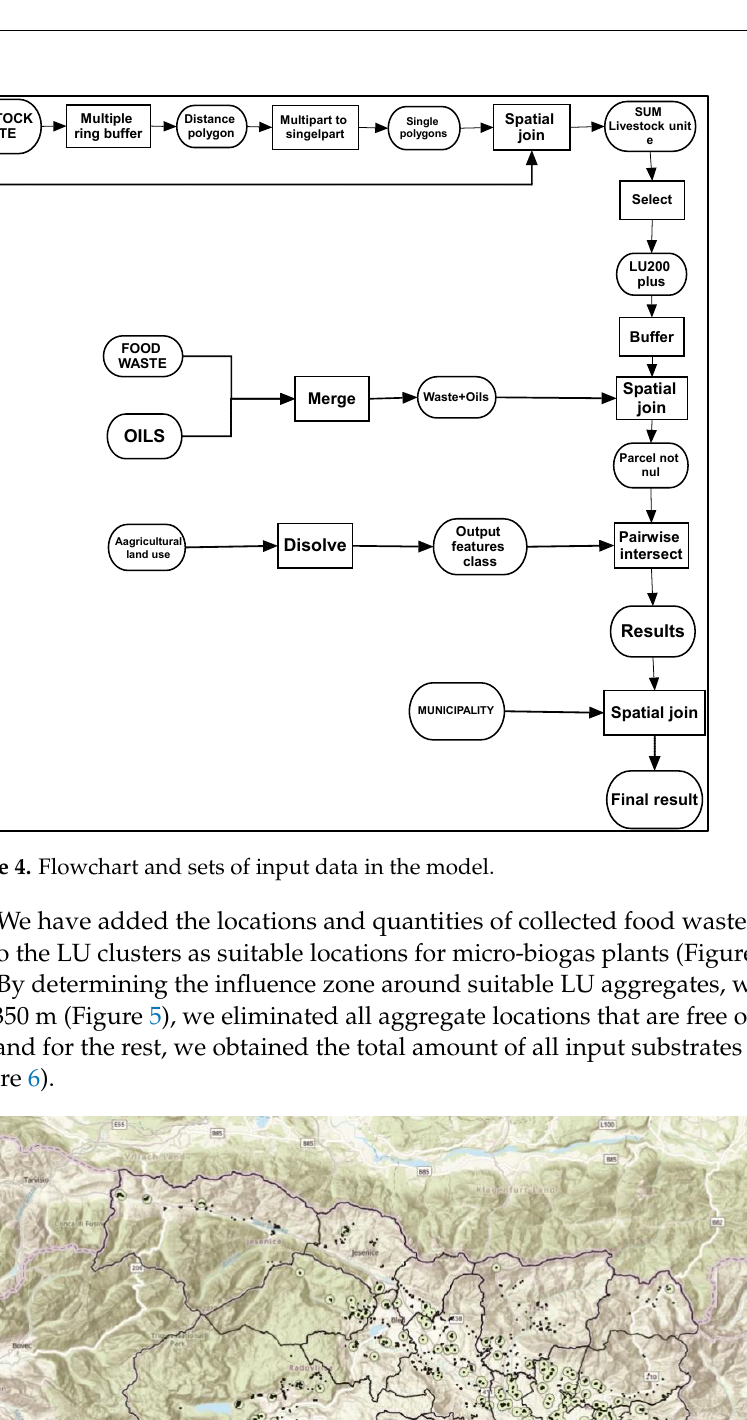
Figure 5. Potentially clusters of LU.